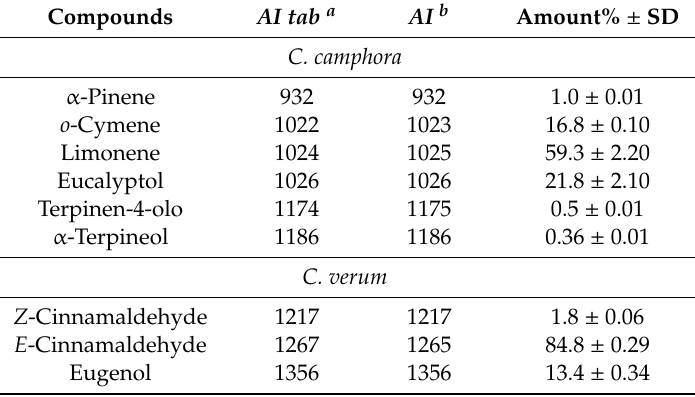
Table 1. Chemical composition of the ten essential oils (EOs) as determined by GC-FID and GC-MS